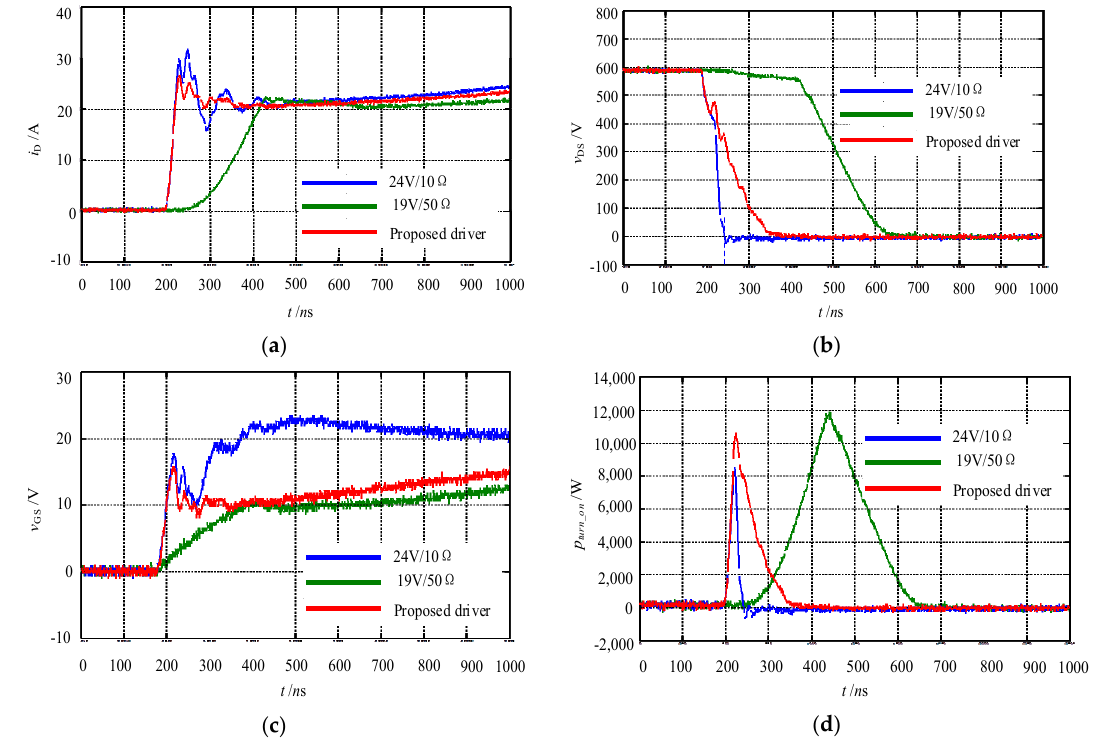
Figure 10. Switching waveforms based on different gate drivers: ( a ) Turn-on current waveforms, ( b ) Turn-on voltage waveforms, ( c ) Gate driving waveforms, and ( d ) Turn-on loss waveforms. The experimental comparison results of the turn-on process are shown in Table 6.